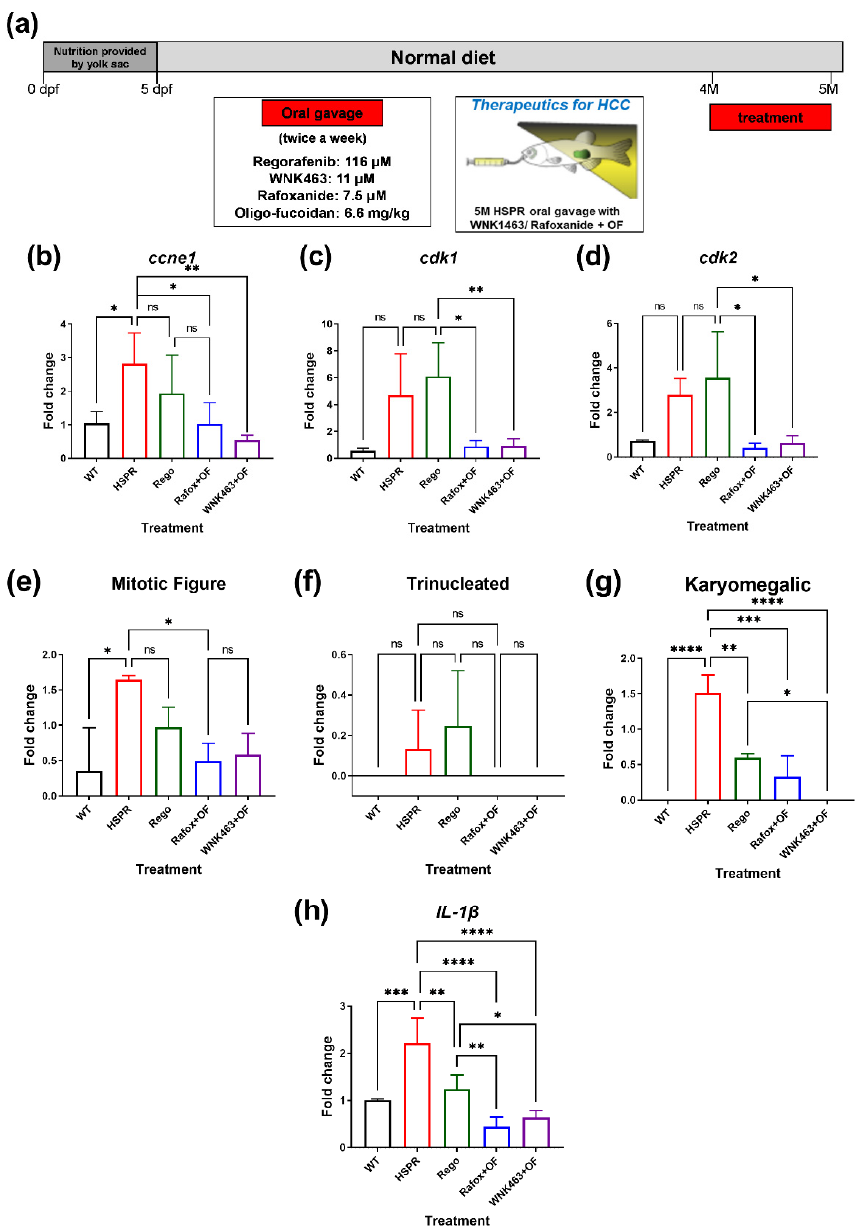
Figure 11. WNK1–OSR1 axis inhibitors combined with oligo-fucoidan attenuate HCC proliferation. ( a ) The treatment scheme of WNK1 and OSR1 inhibitors combined with oligo-fucoidan in [ HBx,src,p53 − / − ,RPIA ] HCC transgenic fish. The expression of proliferation markers ( b ) ccne1 , ( c ) cdk1 , and ( d ) cdk2 in various combinations of drug-treated 5-month-old [ HBx,src,p53 − / − ,RPIA ] (HSPR) transgenic fish compared to WT. Rego: Regorafenib, Rafox: Rafoxanide as OSR1 inhibitor; WNK463 as WNK1 inhibitor; OF: oligo-fucoidan. The quantification of the histopathological features derives from H&E stain: ( e ) mitotic figures, ( f ) trinucleated hepatocytes, ( g ) karyomegalic cells in various combinations of drug-treated 5-month-old [ HBx,src,p53 − / − ,RPIA ] transgenic fish compared to WT. ( h ) The expression of cell senescence marker il1 β in various combinations of drug-treated 5-month-old [ HBx,src,p53 − / − ,RPIA ] (HSPR) transgenic fish compared to WT. We performed three replicates, and for each qPCR, there are triplicates for each sample. Five adult fish are included in each experi- ment. One-way ANOVA analysis followed by multiple analysis of variance was used to identify the statistical significance between groups. *: p (cid:53) 0.05; **: p (cid:53) 0.01; ***: p (cid:53) 0.001; ****: p (cid:53) 0.0001; ns: